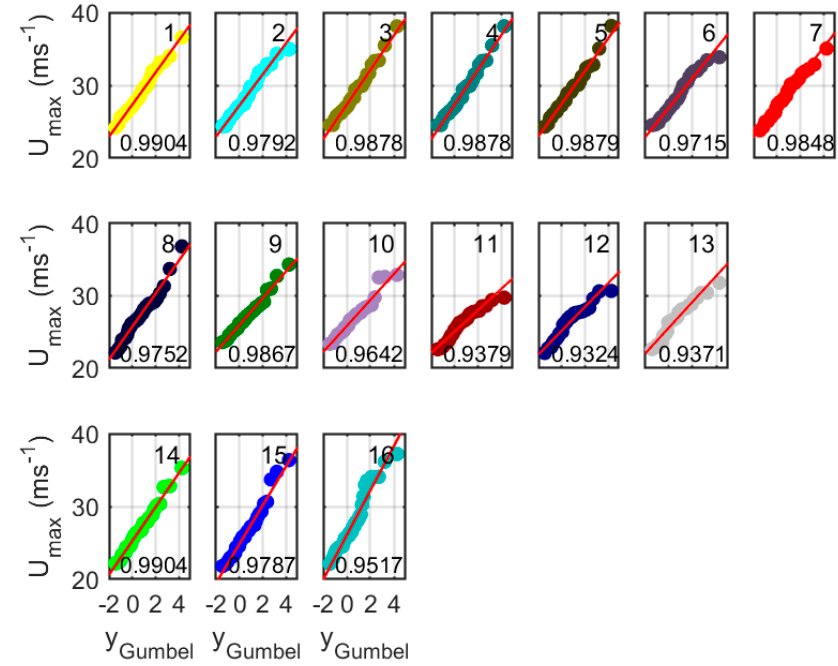
Figure 6. Gumbel-Graphical plots of the ranked annual maximum wind speeds U max against the reduced Gumbel variate y (see Equations (7)–(9)) for the 16 LA (shown in the upper right on each panel). The color coding is as in Figures 1 and 2. The north LA are shown in the top row, the mid LA in the central row and the south LA in the bottom row. The LA numbers are indicated in the top right of each panel. The coefficient of determination r 2 is given for each site at the bottom of each panel.